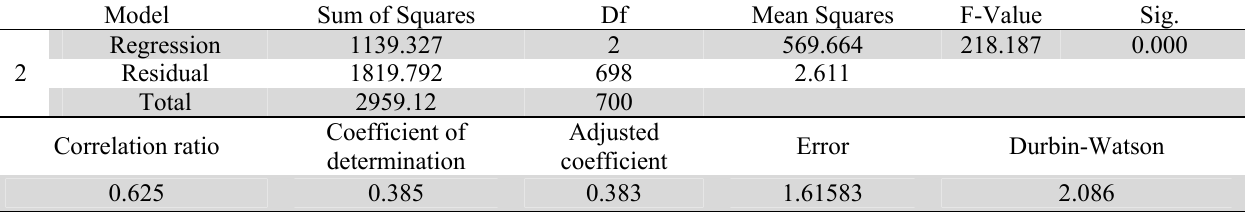
The summary of ANOVA test as well as other statistics for the second regression model Model Sum of Squares Df Mean Squares F-Value